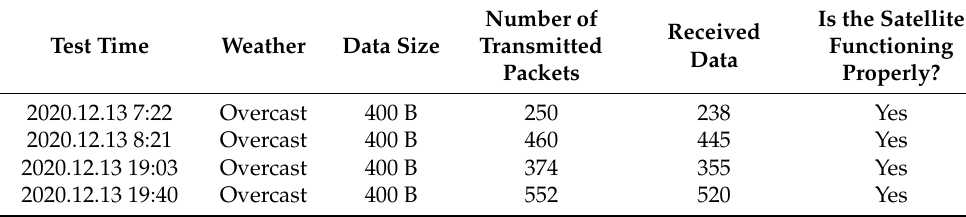
Table 7. Throughput (with the packet creation